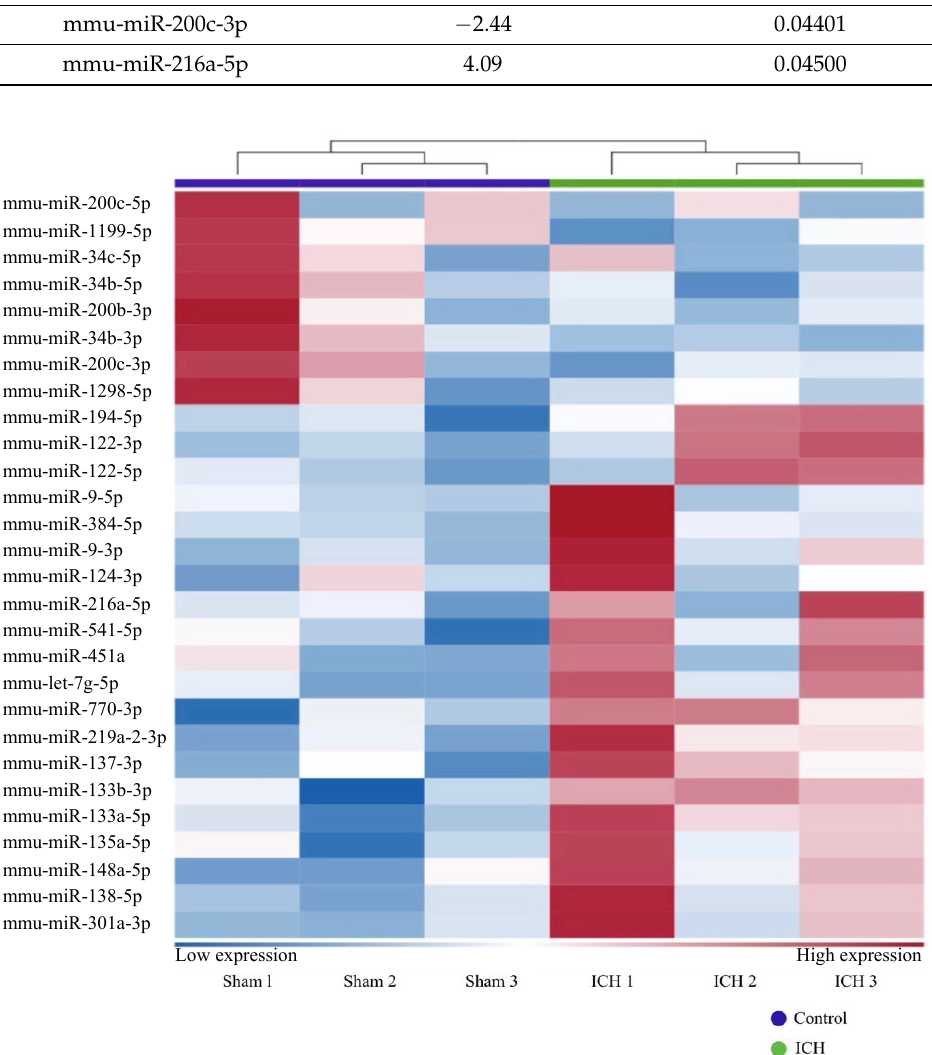
Low expression High expression